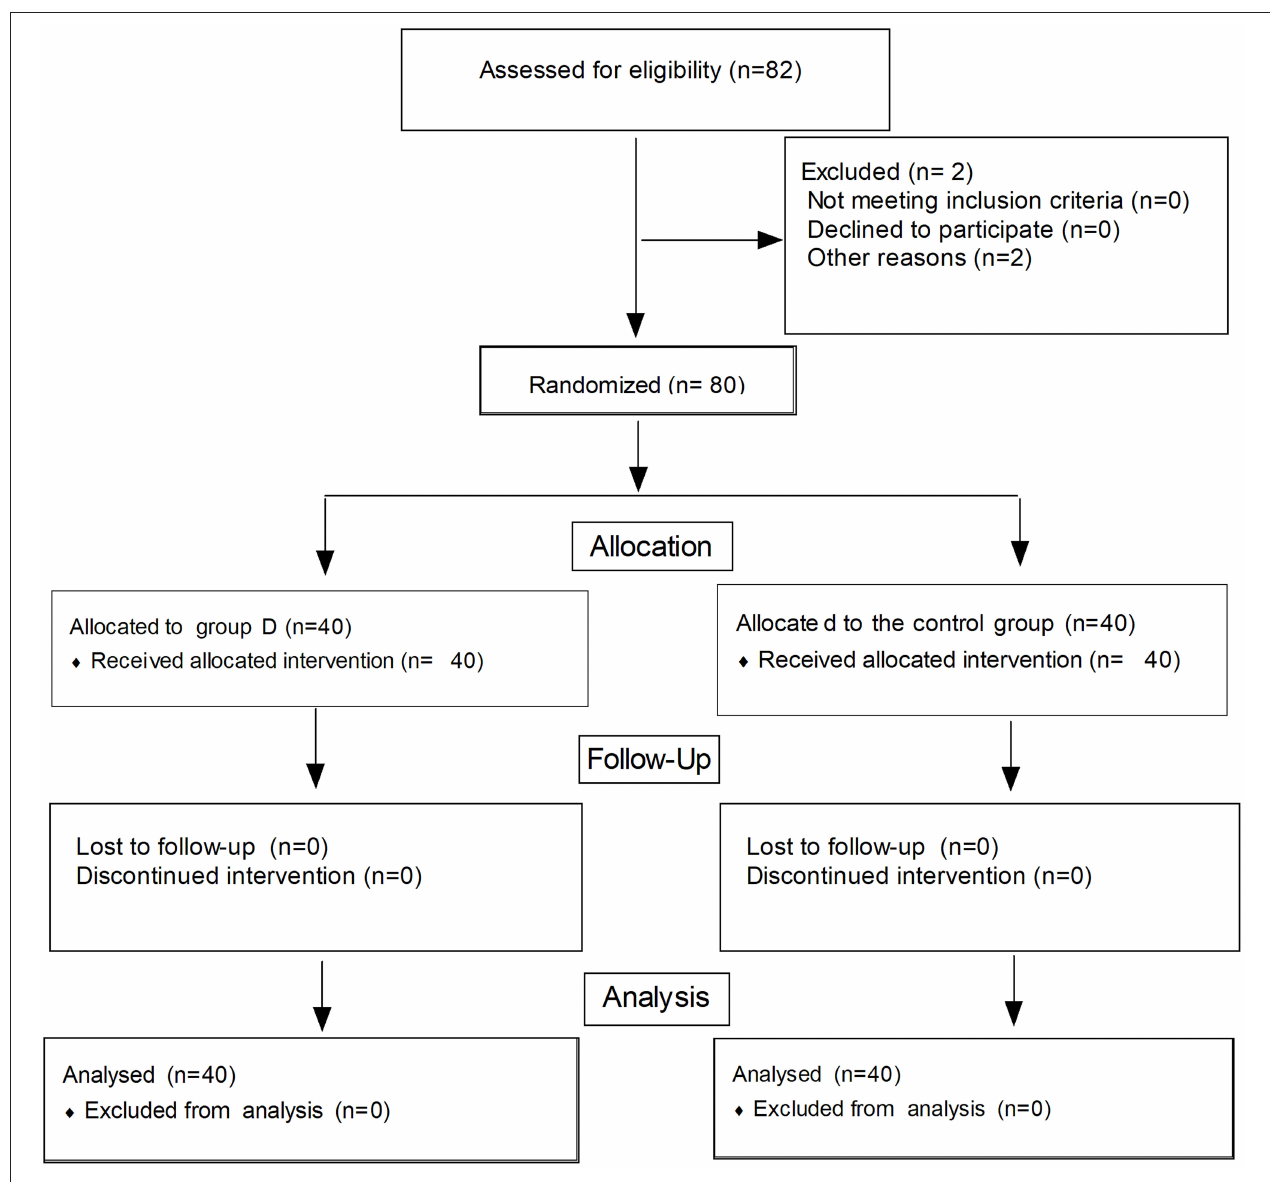
FIGURE 2 | Flow diagram of the